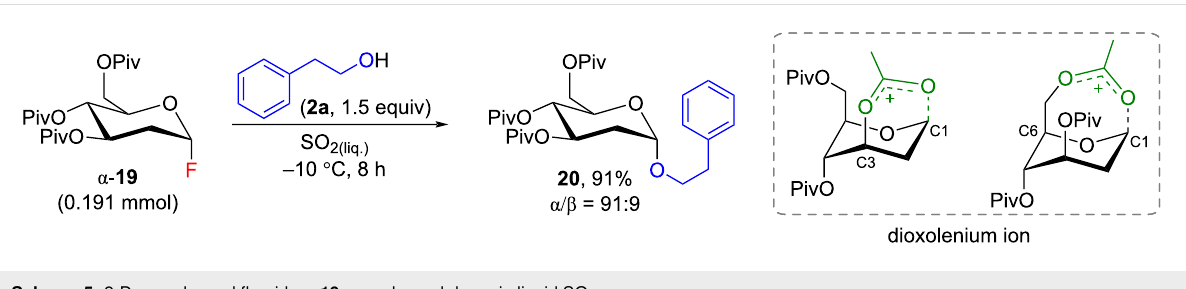
Scheme 5: 2-Deoxy glycosyl fluoride α - 19 as a glycosyl donor in liquid SO 2